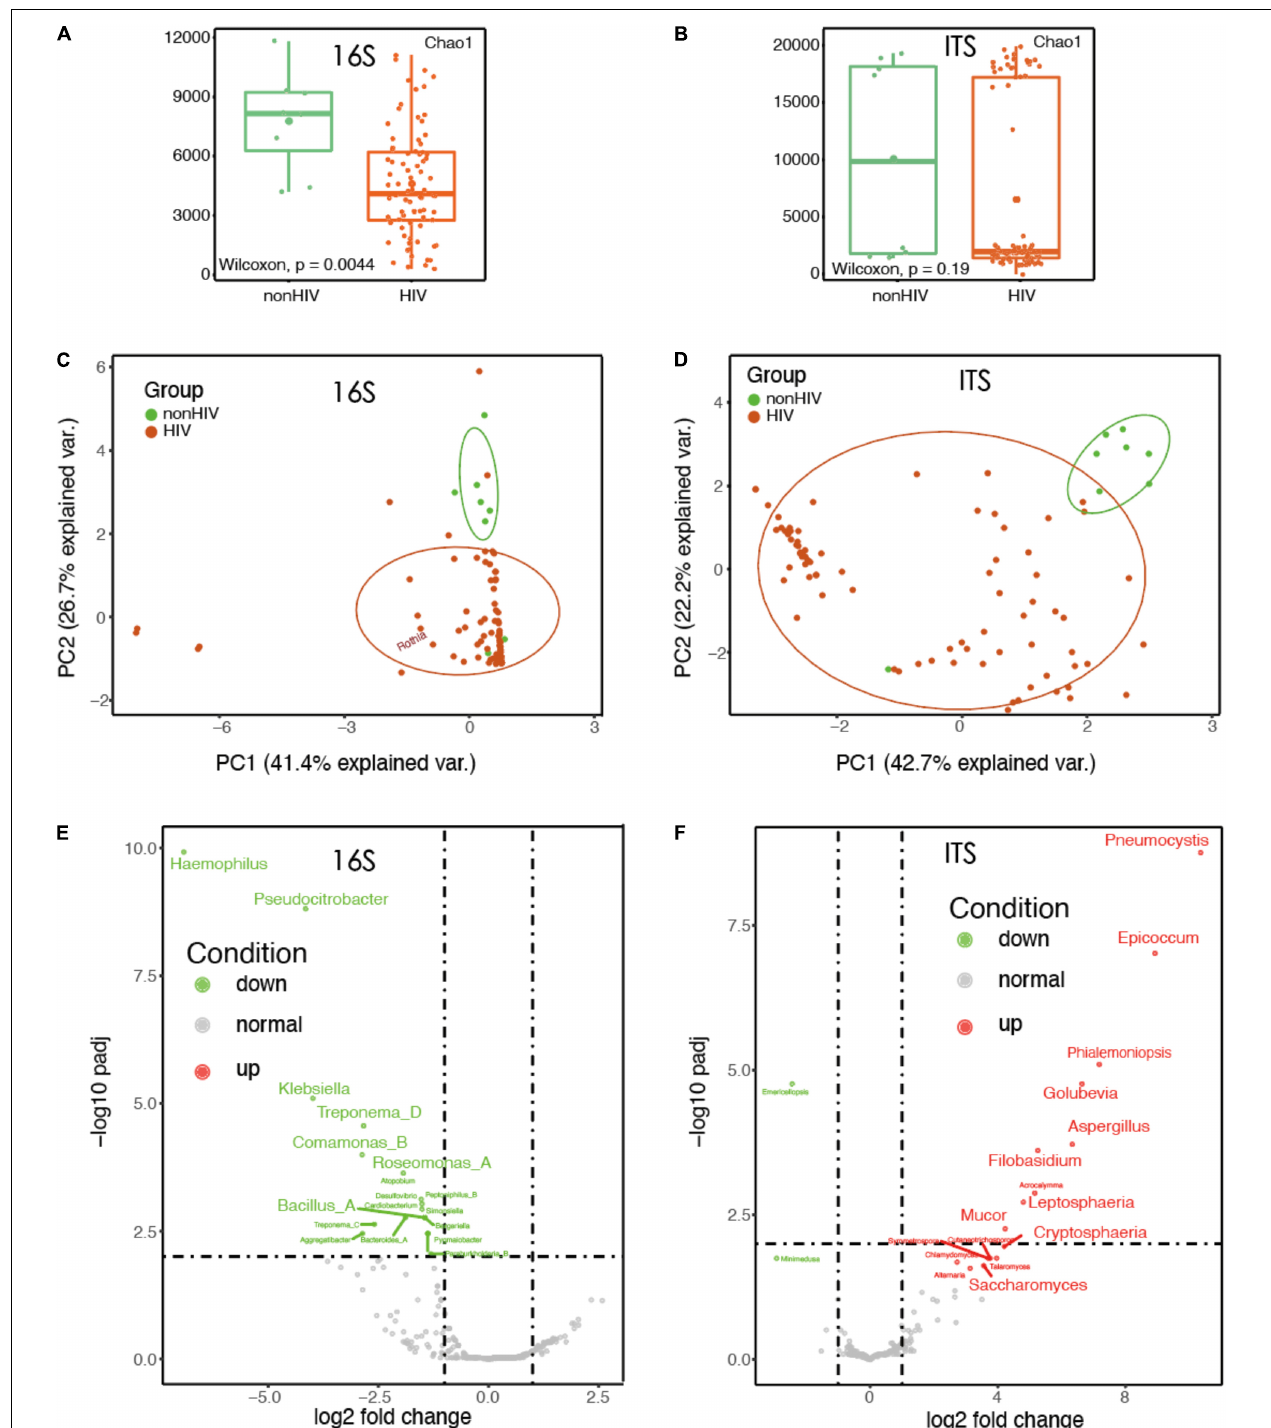
FIGURE 1 | The diversity of HIV-infected microbiota decreased and the structure of the bacteria changed. (A) Comparison of bacterial alpha diversity in BALF at the genus level between HIV-negative individuals and HIV-positive individuals treated with HAART. (B) Comparison of fungal alpha diversity in BALF fluid at the genus level between HIV-negative individuals and HIV-positive individuals treated with HAART. (C) Principal coordinates analysis (PCoA) using a Bray–Curtis dissimilarity of BALF sample (16S rRNA; n = 88) bacterial community profiles, representatively rarefied to 38,721 reads/sample. (D) Principal coordinates analysis (PCoA) using a Bray–Curtis dissimilarity of BALF sample (ITS rRNA; n = 88) fungal community profiles, representatively rarefied to 58,677 reads/sample. (E) Volcano plots of genus-level taxonomic bins in the 16S rRNA gene datasets. The x -axes display the fold changes in relative abundance (log 2). (F) Volcano plots of genus-level taxonomic bins in the ITS rRNA gene datasets. The x -axes display the fold changes in relative abundance (log 2).